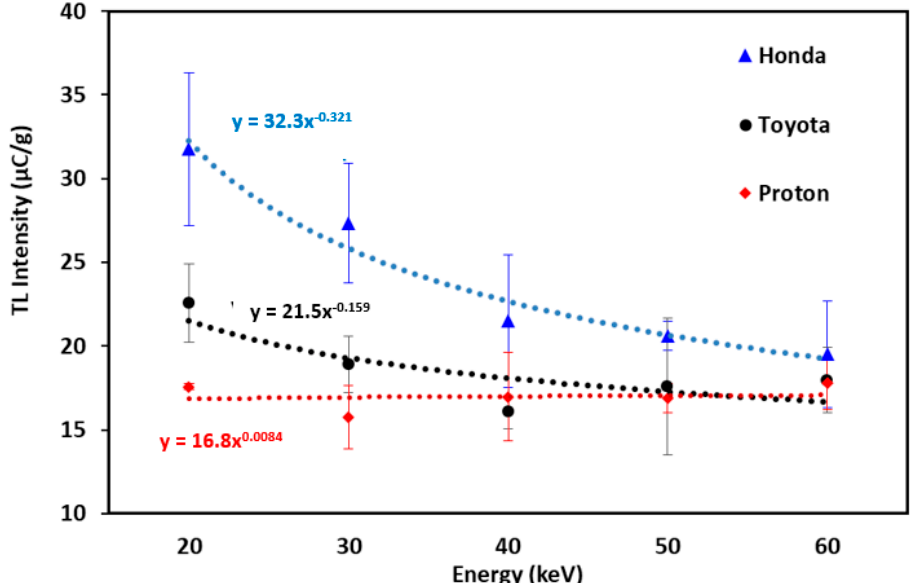
Figure 6. TL response as a function of effective energy (20–60 keV), the samples being subjected to X-ray irradiation.